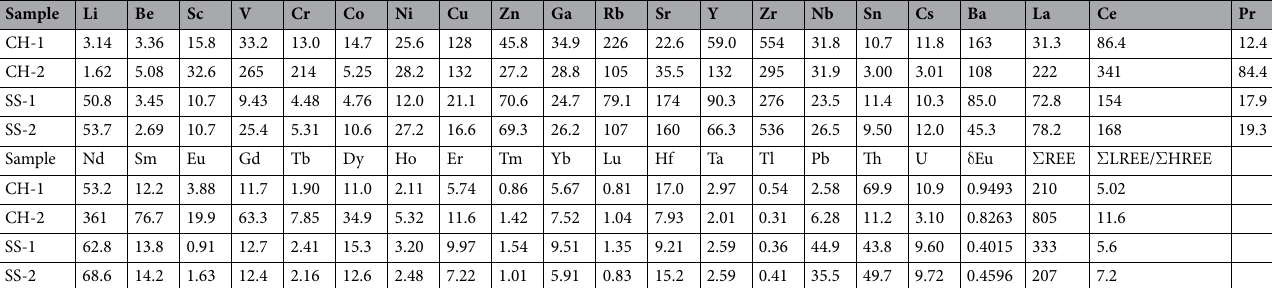
Table 2. Tace elements data of the volcanic ashes (10 − 6 ). Note: δ Eu = Eu/Eu * = Eu CN /(Sm CN × Gd CN ) 1/2 , the subscript CN denotes chondrite-normalized, normalization values are after Sun and McDonough 37 .